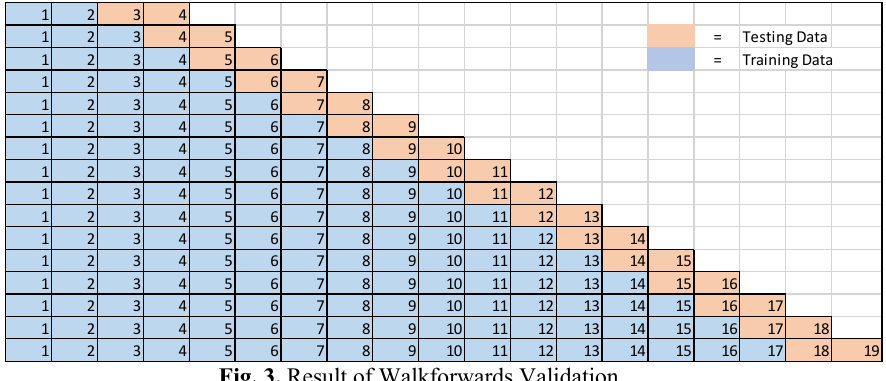
Fig. 3. Result of Walkforwards Validation